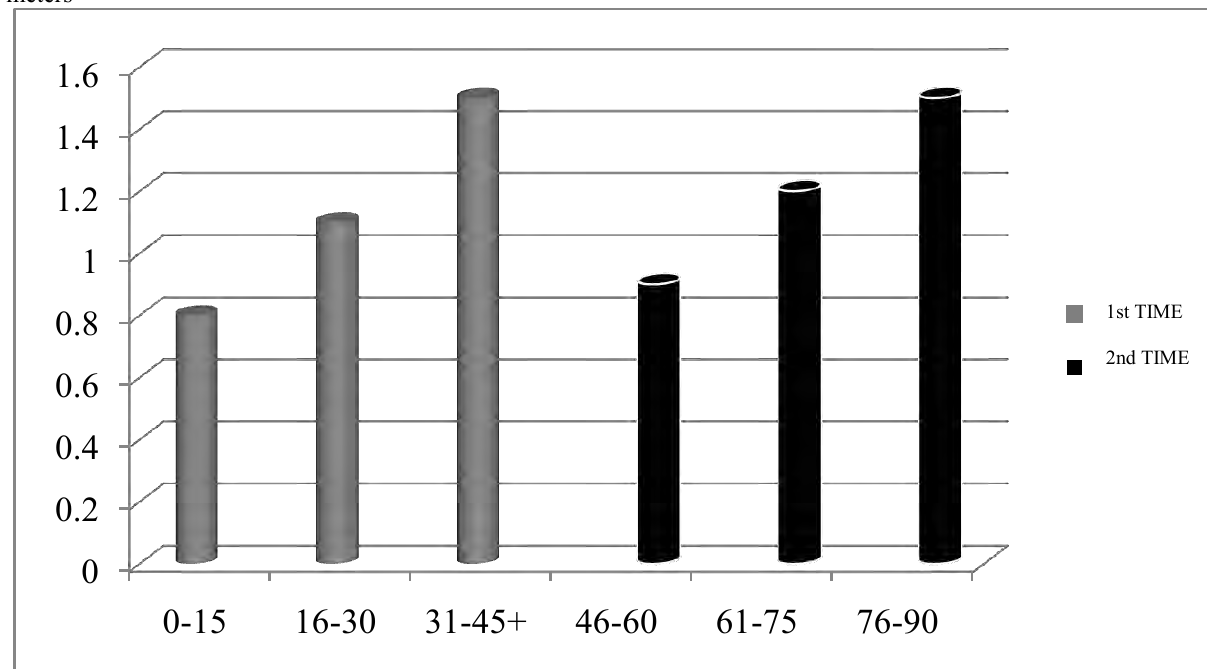
Fig.4. Mean quantity of referees’ wrong decisions on interpretation of rules and on stoppages of match (differentiated by 15 minutes’ periods)